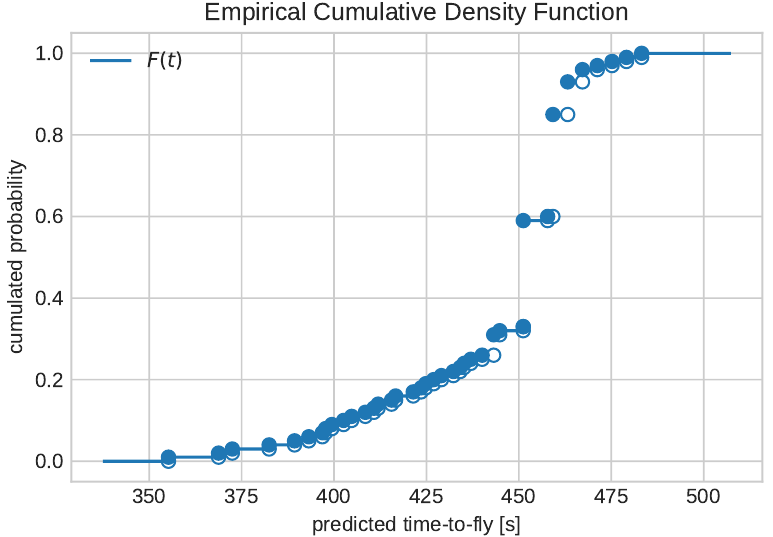
Figure 8. Plot of inverse quantile function, which results in a right-continuous empirical cumulative distribution